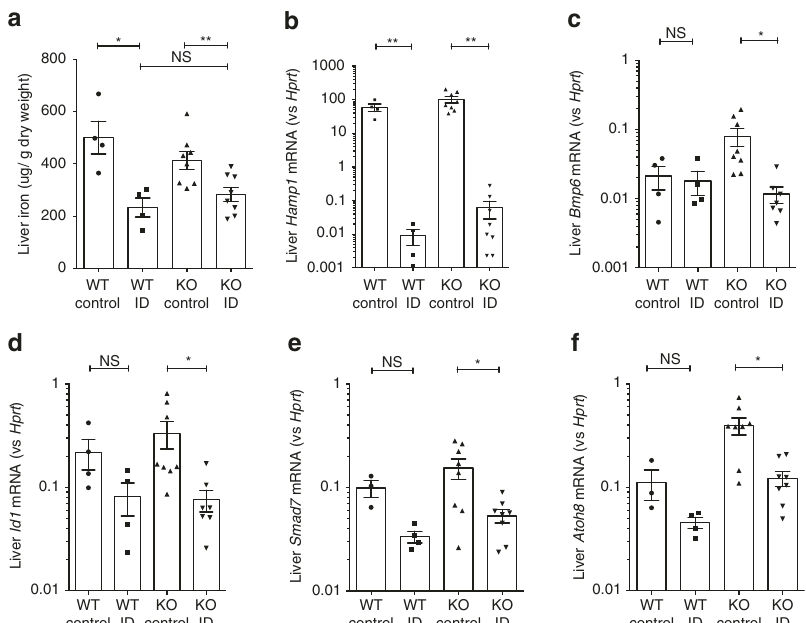
Fig. 2 Effects of ID in Fam132b knockout mice. Effects of 3-week iron-de fi cient diet compared with control diet in 5-week-old wild-type and Fam132b knockout mice, on a liver iron content, b hepatic Hamp1 mRNA expression, c hepatic Bmp6 mRNA expression, d hepatic Id1 mRNA expression, e hepatic Smad7 mRNA expression, and f hepatic Atoh8 mRNA expression (WT mice, N = 4 per group. KO mice, N = 8 per group). Student ’ s t -test. Data are means